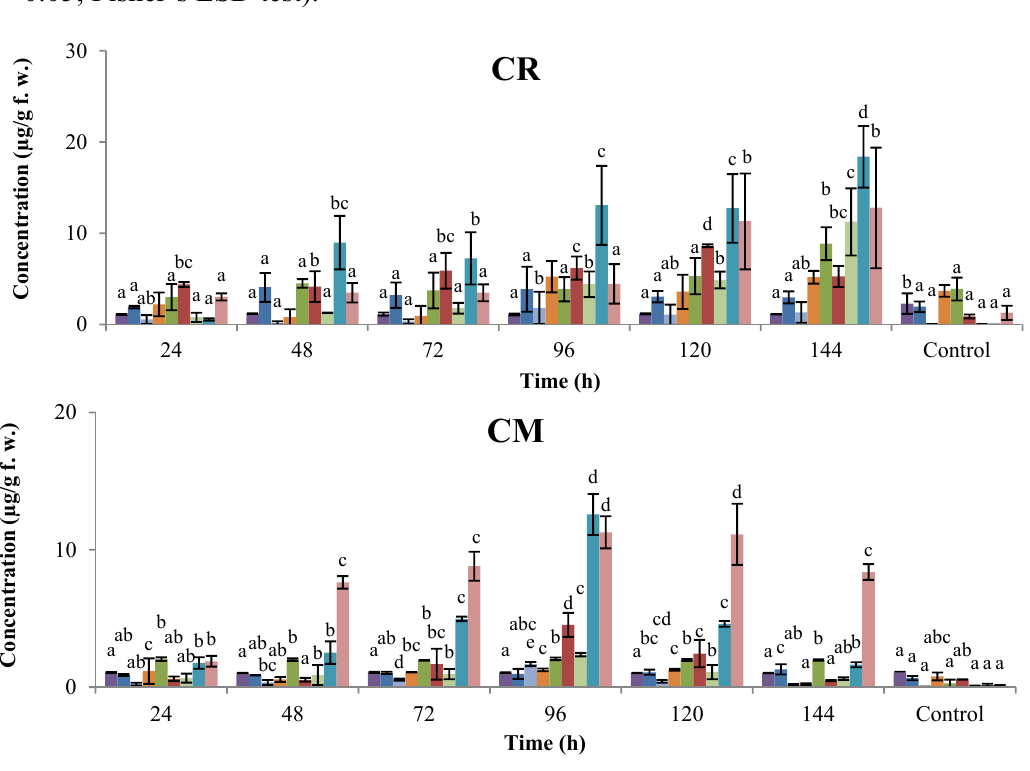
Figure 2. Time-course accumulation of phytoalexins in common bean cotyledons treated with